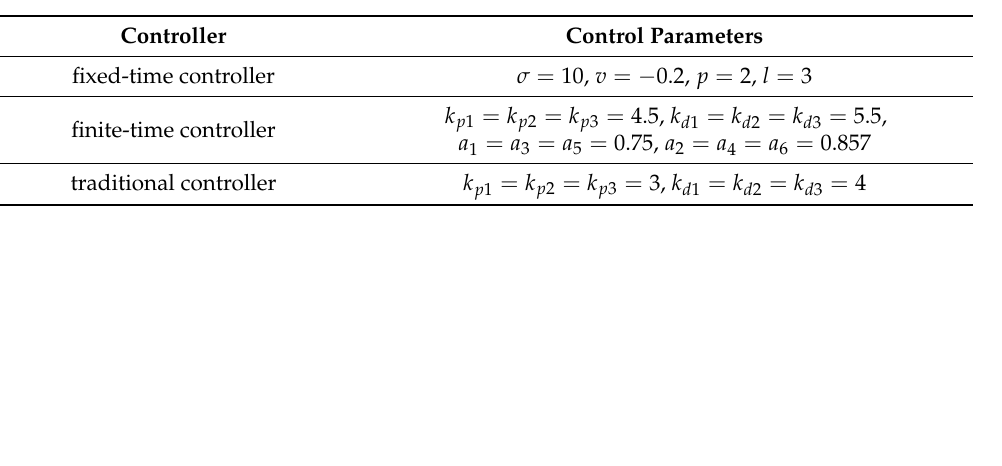
Table 4. The control parameters in the